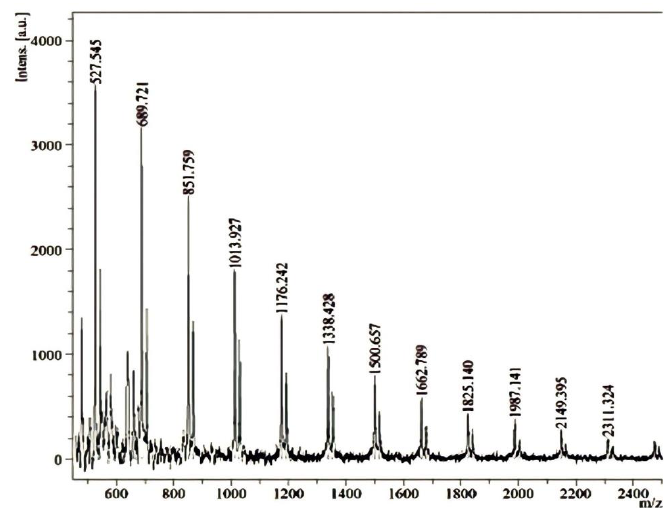
Figure 1. MALDI-TOF-MS mass spectrum of agavin from A. tequilana Weber, blue variety, with 2,5- dihydroxybenzoic acid as the matrix. All m/z values correspond to [MþNa]þ and [MþK]þ adducts.